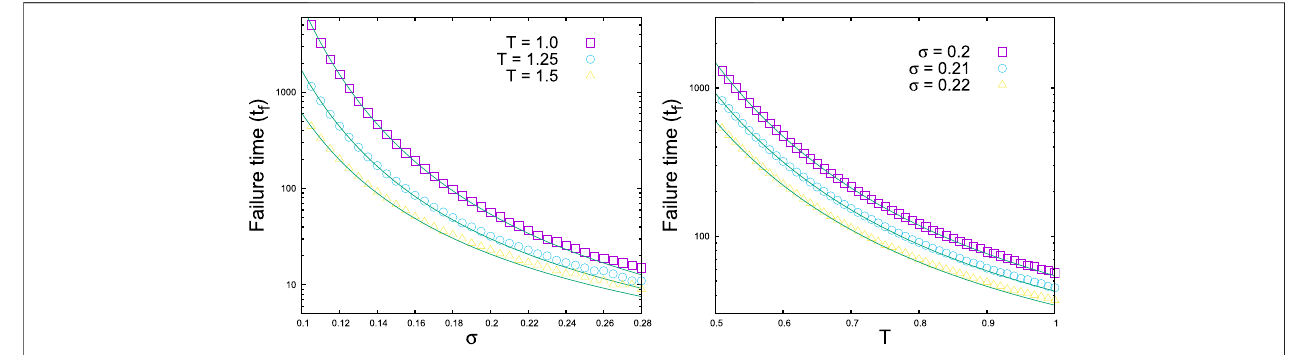
FIGURE 7 | Failure time versus σ (left) and versus T (right) for a homogeneous bundle having identical fi bers with a strength of 1 ( σ c (cid:1) 1 as well). The data are for simulations over a single realization with a system size of N (cid:1) 1000000, and the solid lines are the theoretical estimates following ( Eq. 55 ).